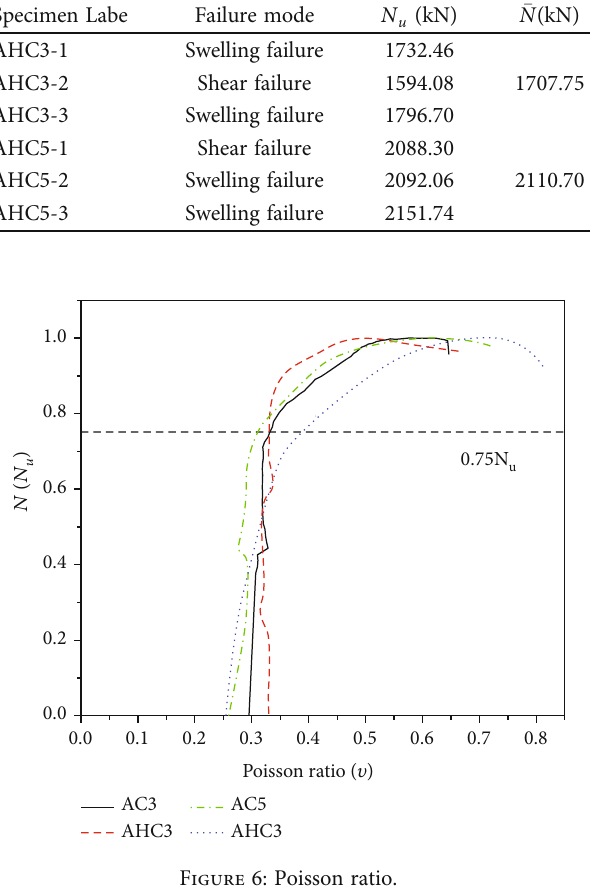
Figure 6: Poisson ratio. Table 6: Ductility index and coe ffi cient of strength improvement. Specimen